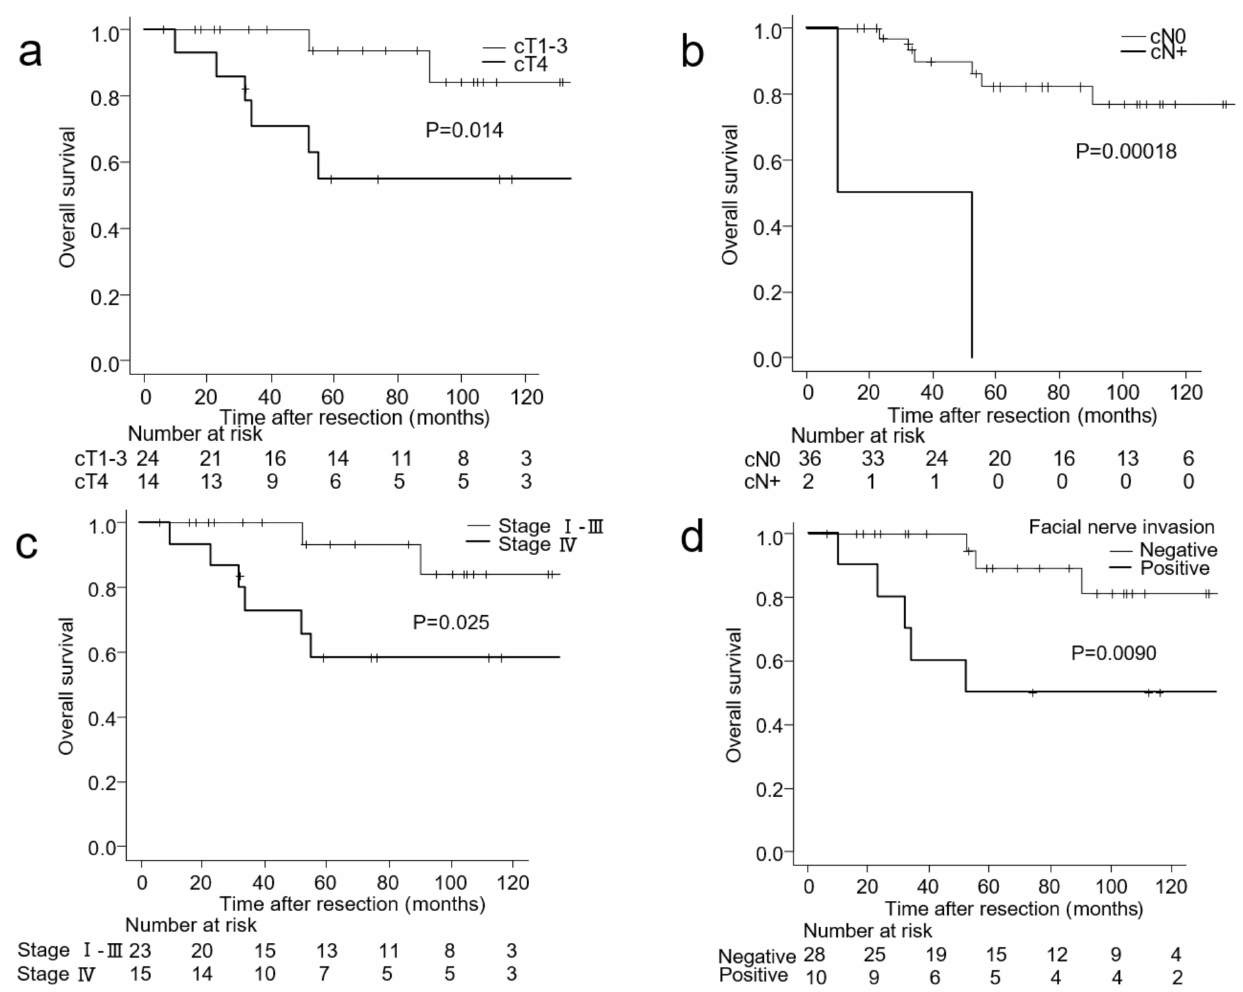
Figure 2. Kaplan–Meier curves of OS of Group B stratified by ( a ) clinical T stage, ( b ) clinical N stage, ( c ) disease stage, and ( d ) intraoperative facial nerve